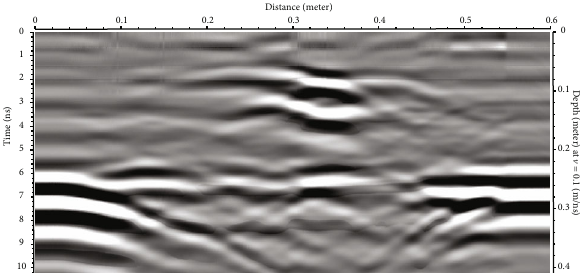
Figure 10: Detection results of a simulated fracture zone.